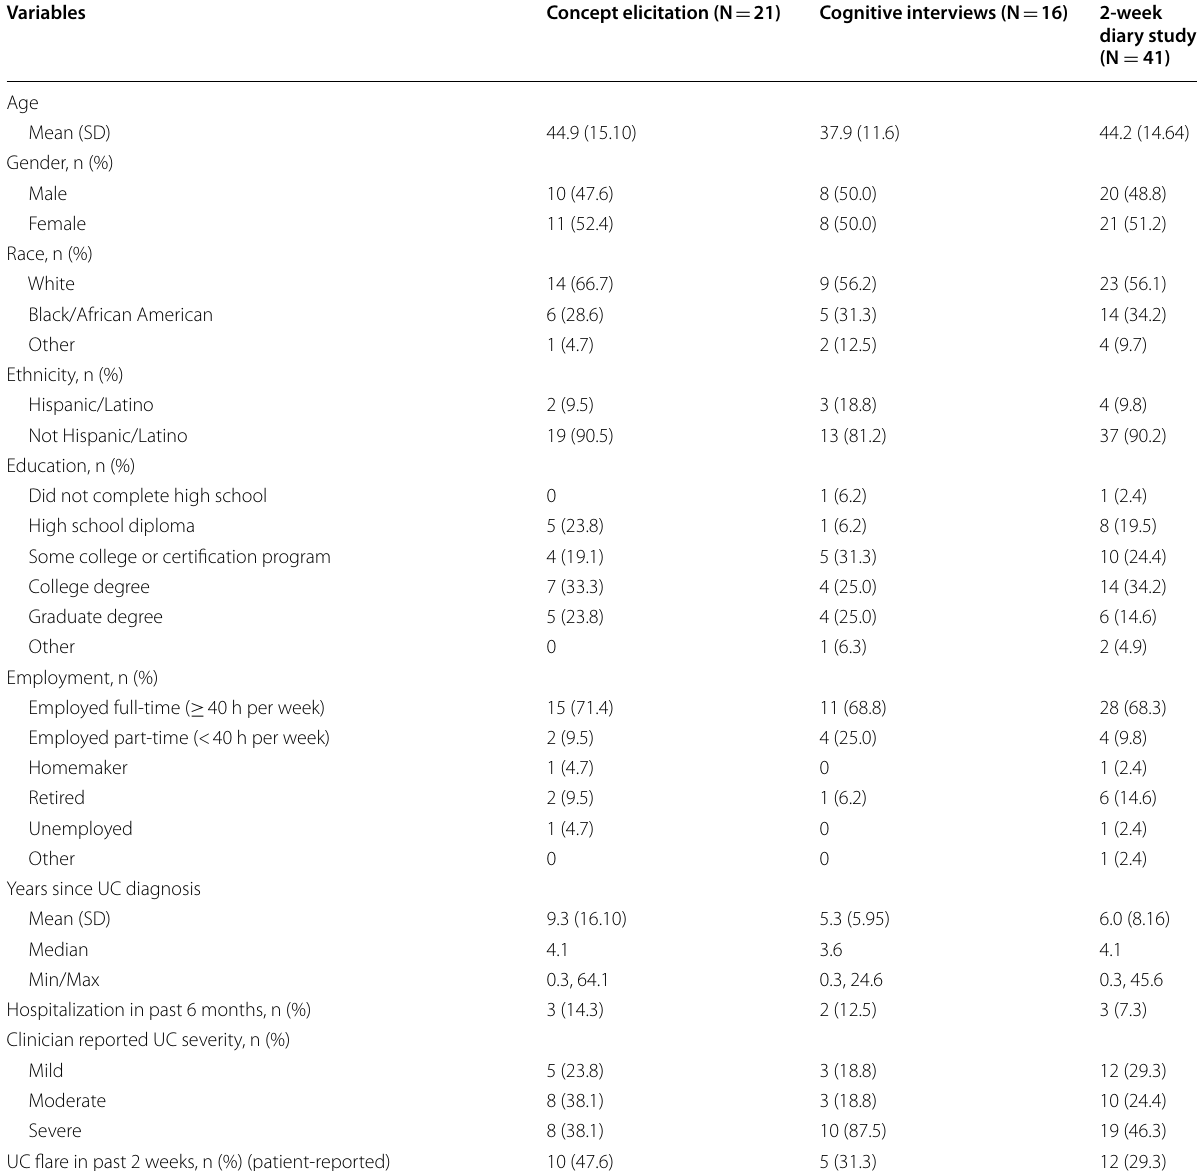
Table 1 Patient demographics and clinical